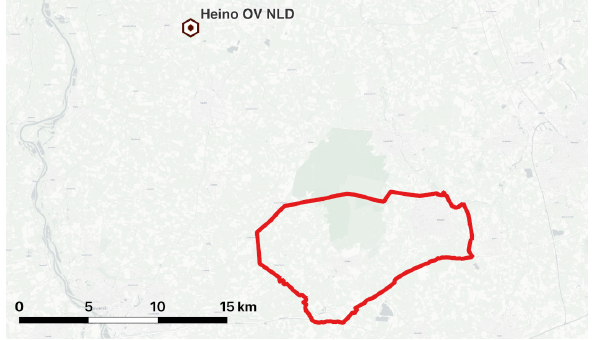
Figure 9. Location of the weather station at Heino, the boundary of Rijssen-Holten is coloured in red 2.6 DTM